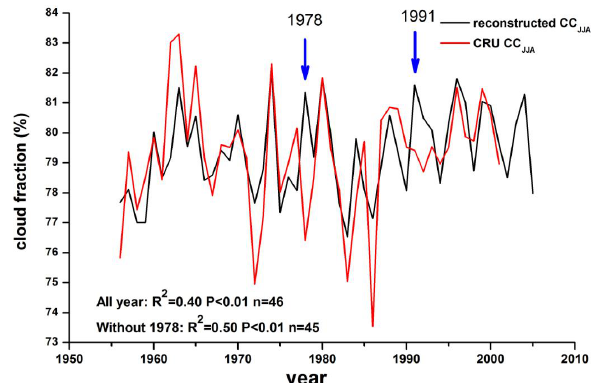
Fig. 3. Reconstructed and CRU June–August cloud covers (CC JJA ) over 1956–2005. The black and red lines are reconstructed and CRU cloud respectively. The blue arrows indicate the outlier years of 1978 and 1991.